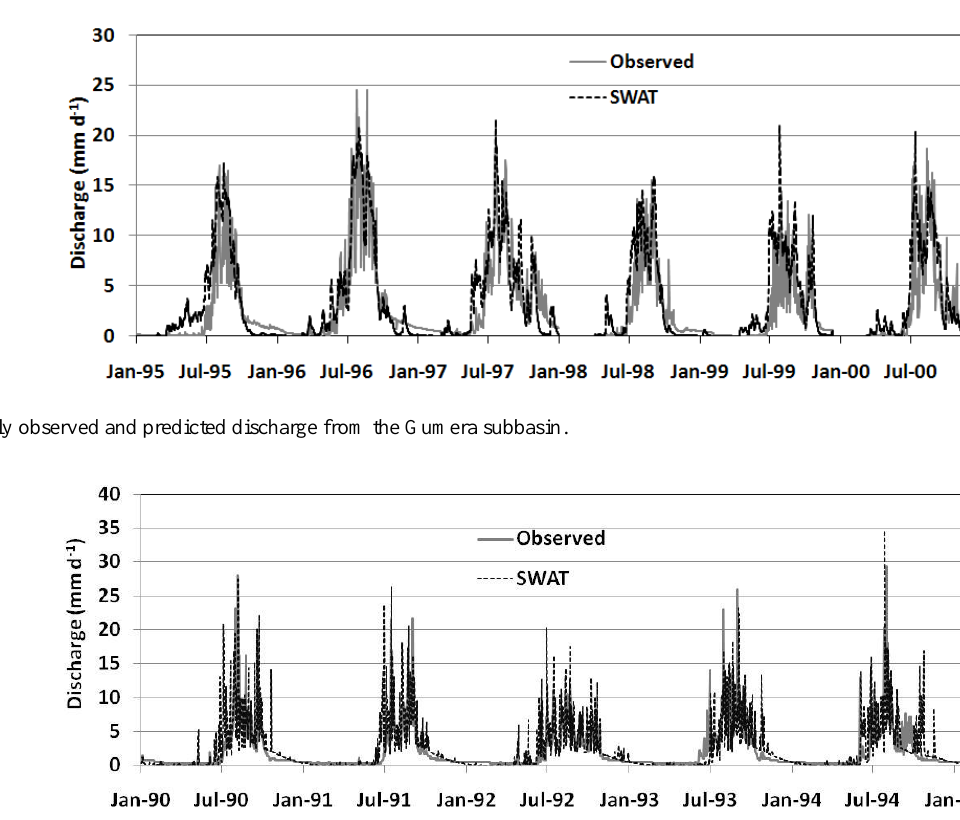
Fig. 7. Daily observed and predicted discharge from the Anjeni micro watershed.